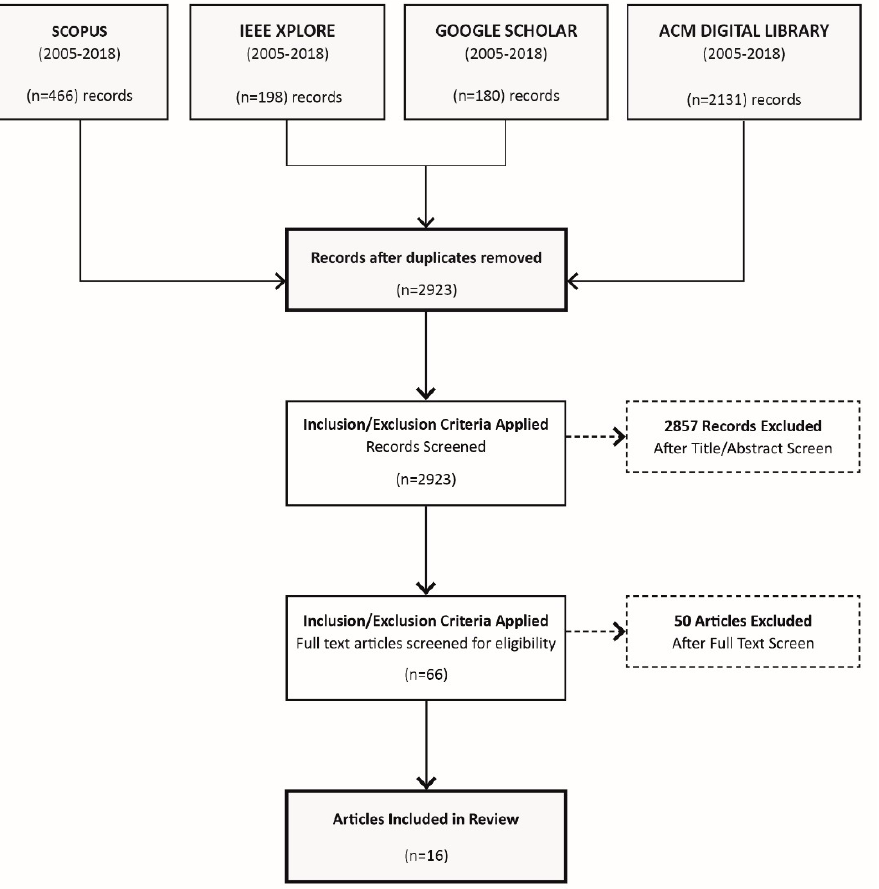
Figure 1. Literature search and assessment using the Preferred Reporting Items for Systematic Reviews and Meta-Analyses (PRISMA) flow diagram.